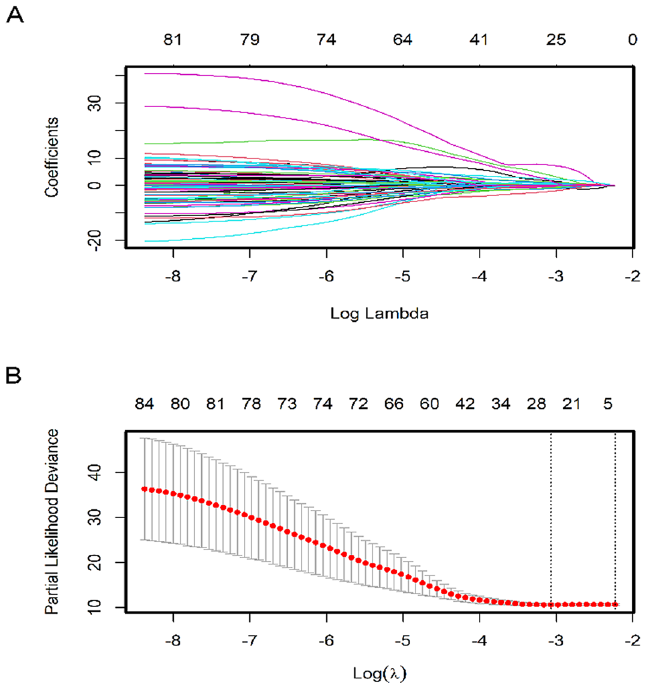
Figure 2. Candidate methylation sites selection on the basis of the LASSO Cox regression model. ( A ) LASSO Cox regression with L1 regularization. Tenfold cross-validation for tuning parameter selection in the LASSO model via minimum criteria (the 1-SE criteria). ( B ) The LASSO Cox regression model was employed to determine the most robust hallmarks. LASSO coefficient profiles of the 84 methylation sites. A coefficient profile plot was created against log (lambda) sequence. Vertical line was used at the value selected by using tenfold cross-validation, where optimal lambda resulted in 25 non-zero